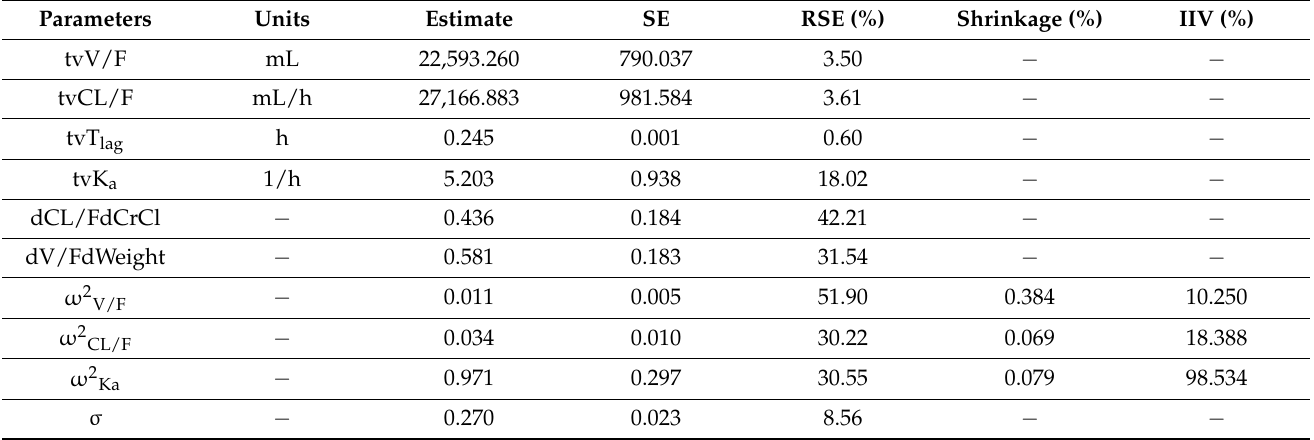
Table 5. Estimated population pharmacokinetic parameters for cefaclor with the final